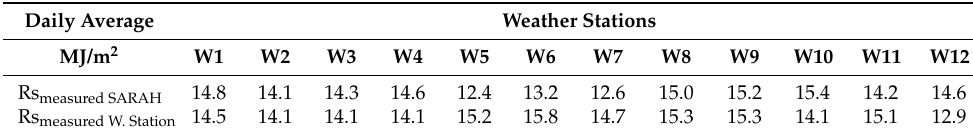
Table 3. Differences in the annual average from 2010 to 2017 of the solar radiation values measured by pyranometers (Rs-measured W. Station) and those measured by the satellite HELIOTSAT-SARAH (Rs-measured SARAH).